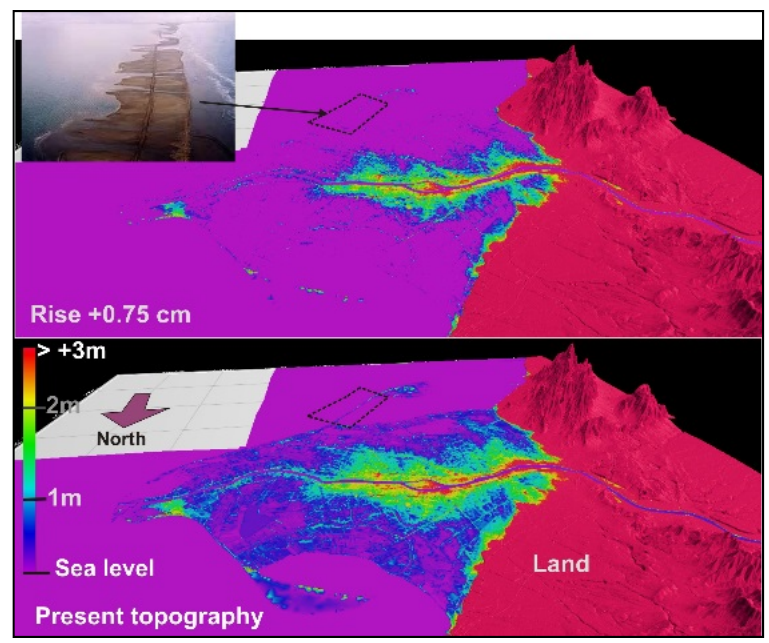
Figure 5. Modelling of the delta morphology with a rise in sea level of 0.75 m and with local subsidence [28].